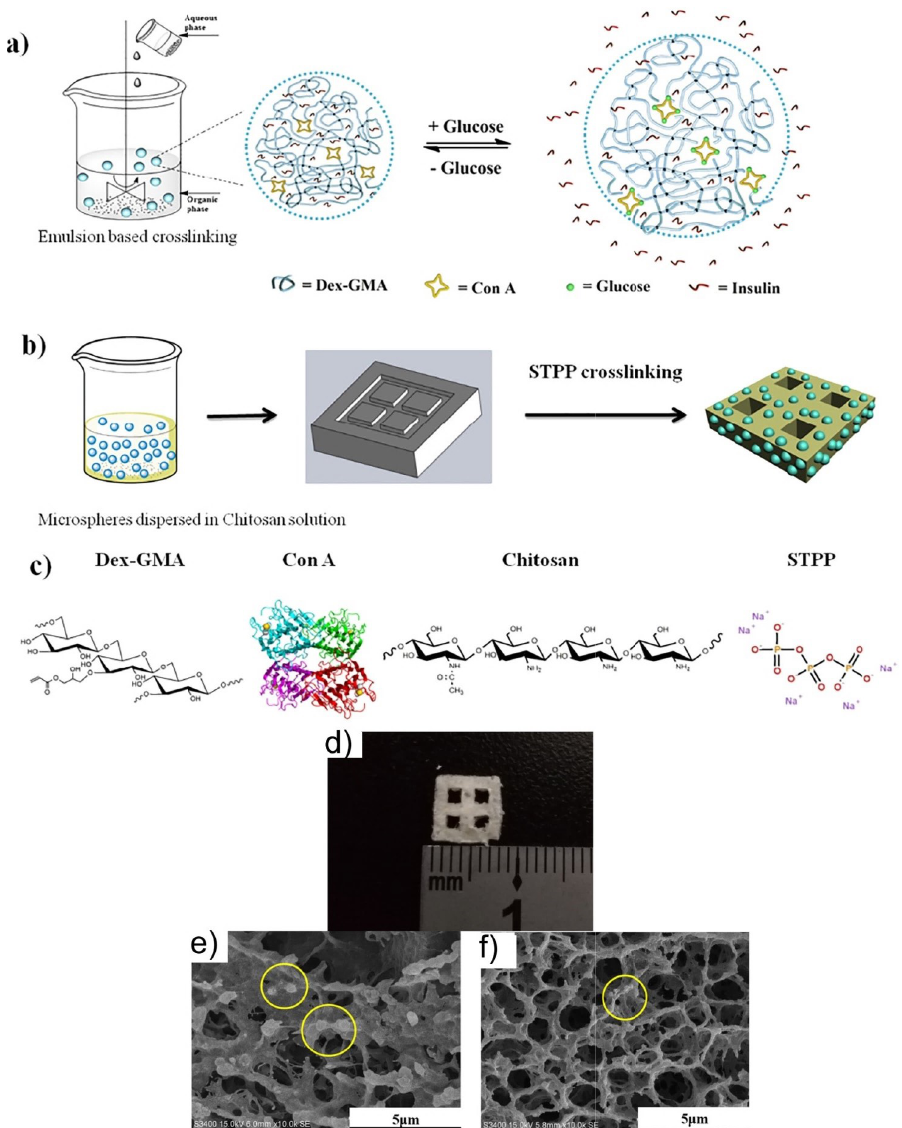
Figure 8. A glucose-sensitive platform: schematic representation of ( a ) synthesis of glucose-responsive microspheres; ( b ) scaffold preparation. ( c ) The chemical structure of system components. SEM images of ( d ) surface, ( e ) cross-section, and ( f ) scaffold containing insulin-loaded microspheres. Reproduced from [105], with permission from © 2018